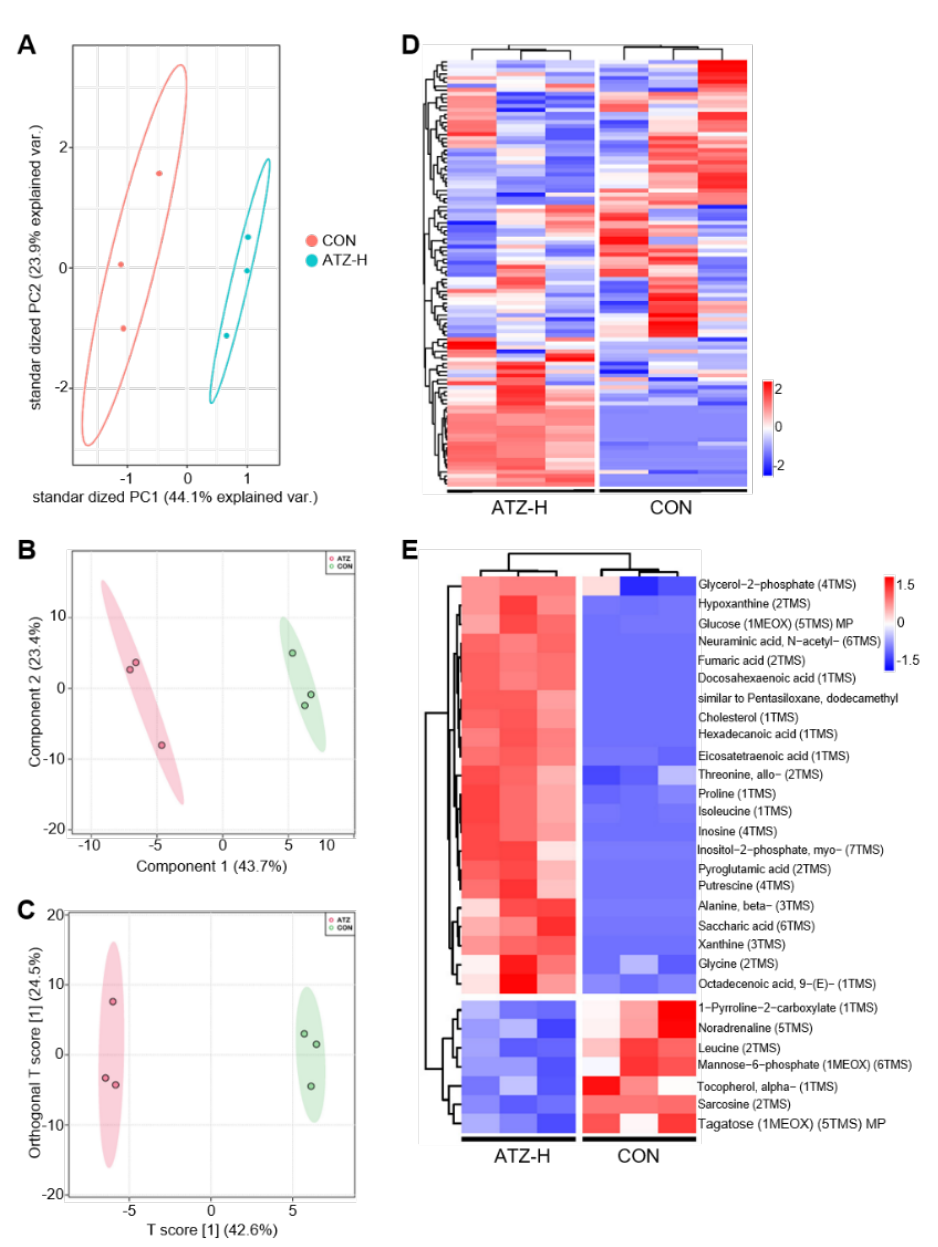
Figure 2. ATZ exposure altered hepatic metabolism in male adult zebrafish. ( A ) Score plots of principal component analysis (PCA) for 1000 µ g/L of ATZ and the control group. ( B ) The PLS − DA and OPLS − DA. ( C ) Analyses of the control group and ATZ − treated group. ( D ) Heat map of liver metabolites in the control and 1000 µ g/L ATZ − treated groups. ( E ) Heat map of significantly ( p < 0.05) different metabolites in the control and ATZ − treated groups.